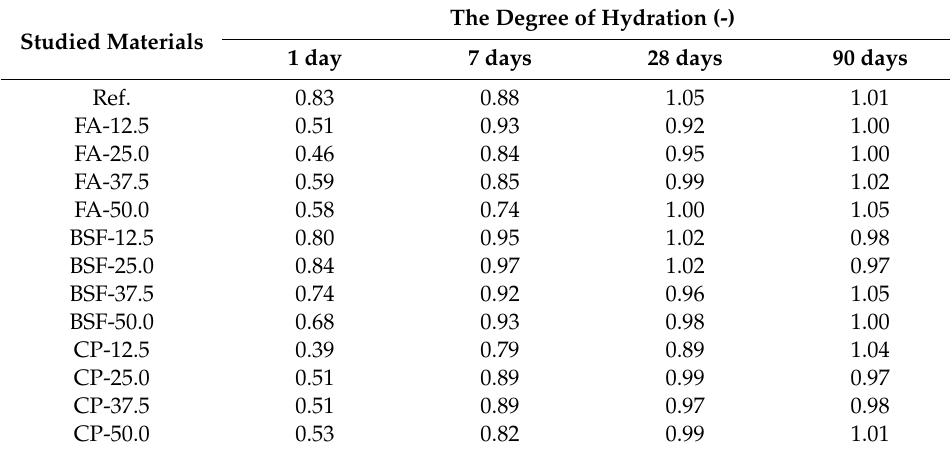
Table 5. The degree of hydration (-) of studied materials in